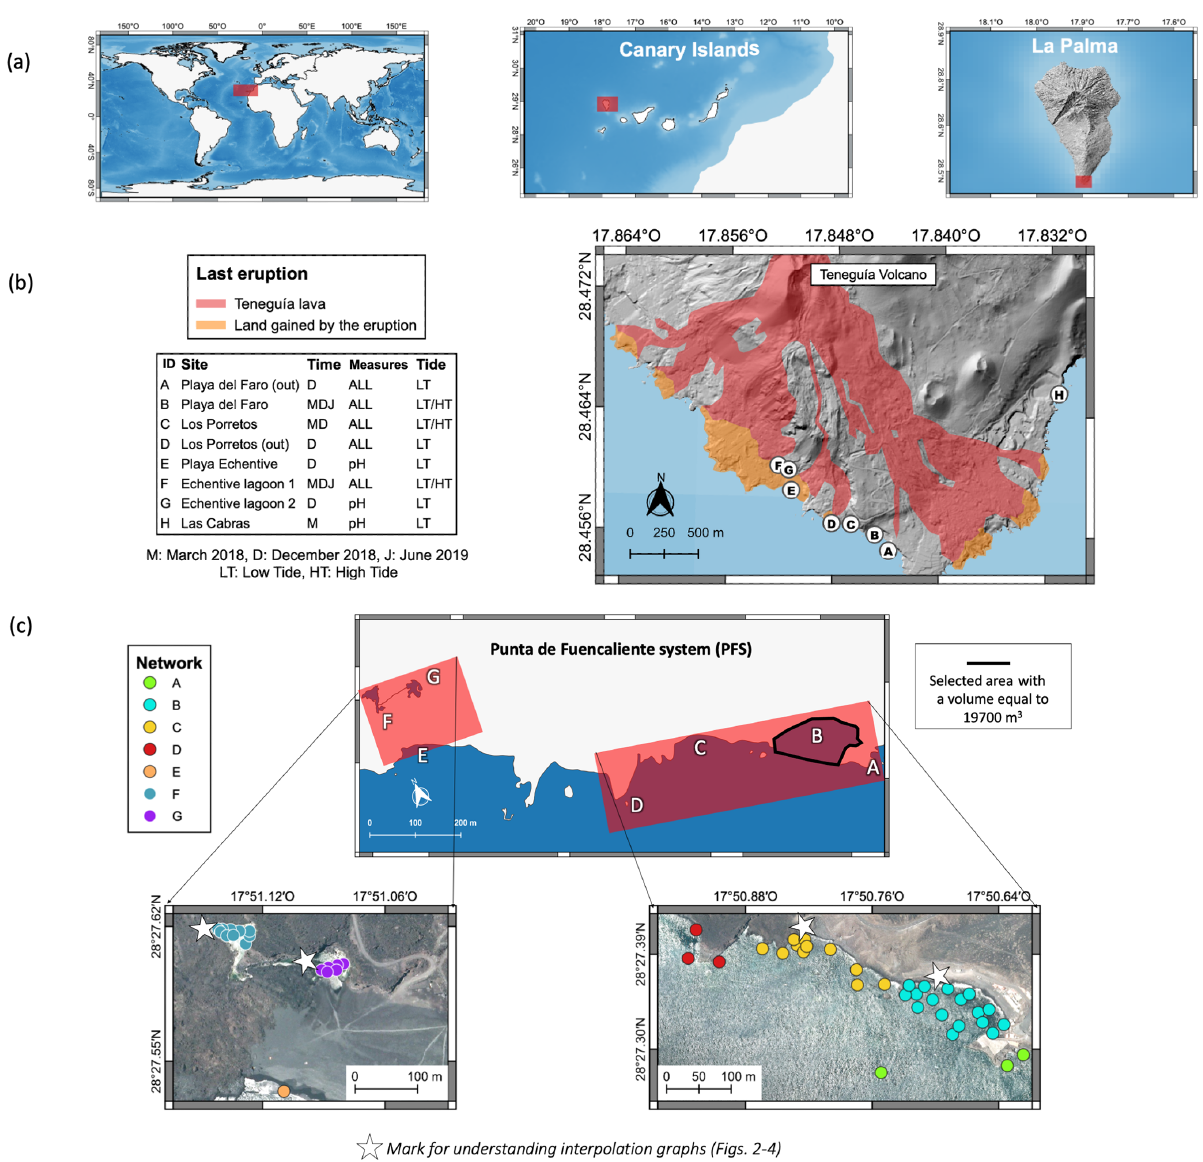
Figure 1. (a) Location of study are in north-eastern Atlantic Ocean, in the west of the Canary Islands, on the south of La Palma. (b) Location of the seven sampling sites (A–G) on the south of the island of La Palma. The location of Punta Las Cabras (H) considered in Hernández et al. (2016) is also included. The area covered by the last volcanic eruption, Teneguía volcano, is also indicated. (c) Location of sampling network performed in this work around the Punta de Fuencaliente system (PFS) and the selected area where the volume was calculated for CO 2 flux calculation. The stars are included as an aid to better interpret and locate the interpolation graphics from Figs. 2–4. The map and image base layers used are distributed in the public domain (https://www.grafcan.es/, last access: 20 September